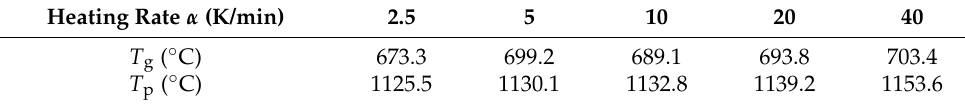
Figure 9. ( a ) DSC curve of the glass granules; ( b ) Linear fitting diagram (ln( T p2 / α ) versus (1000/ T p ) of glass granules. Table 5. Tg and Tp values of the glass granules at different heating rates.